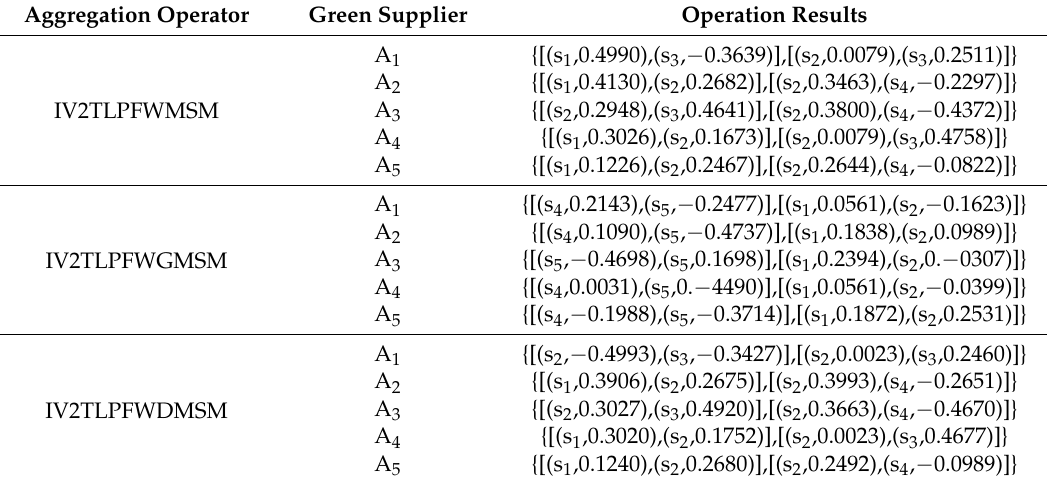
Table 2. The operation results by the IV2TLPFWMSM, IV2TLPFWGMSM, and IV2TLPFWDMSM operators.